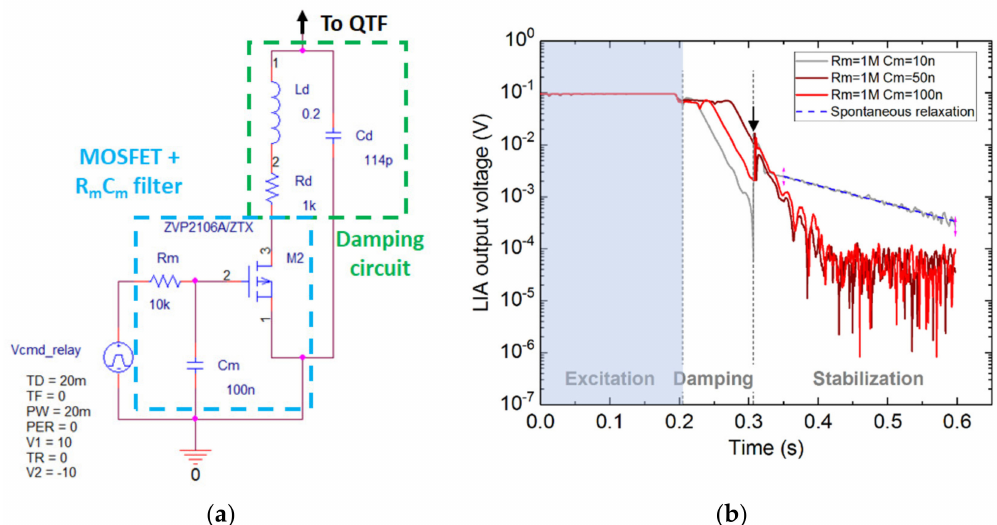
Figure 6. ( a ) PSPICE schematic of the damping circuit and the MOSFET inserted in the RL branch. The MOSFET gate is driven by a voltage source connected to a low pass RC filter. ( b ) Observing the QTF response to damping for different values of the filter capacitance C m . The damping is enabled just after the end of the excitation by applying a negative voltage to the MOSFET gate. The arrows indicate the moment the MOSFET was turned off, that is 100 ms after the onset of the